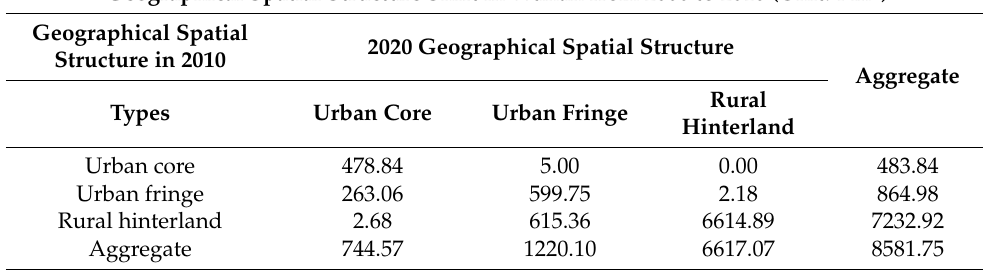
Table 6. Changes in land-use types in Wuhan from 2000 to 2020. Geographical Spatial Structure Shift in Wuhan from 2000 to 2010 (Unit: km 2 )